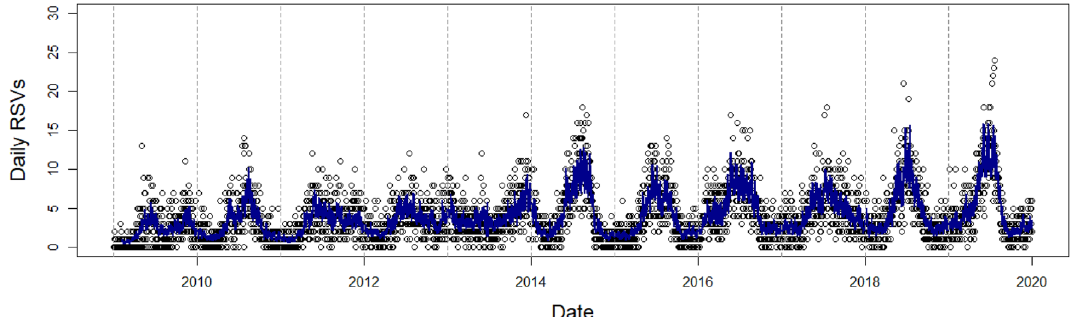
Figure 2. Time series of reported and predicted number of RSV infections, 2009–2019. The hollow circles represent the reported daily counts of RSV infections and the blue solid line represents the daily number of RSV infections predicted from the final PM 2.5